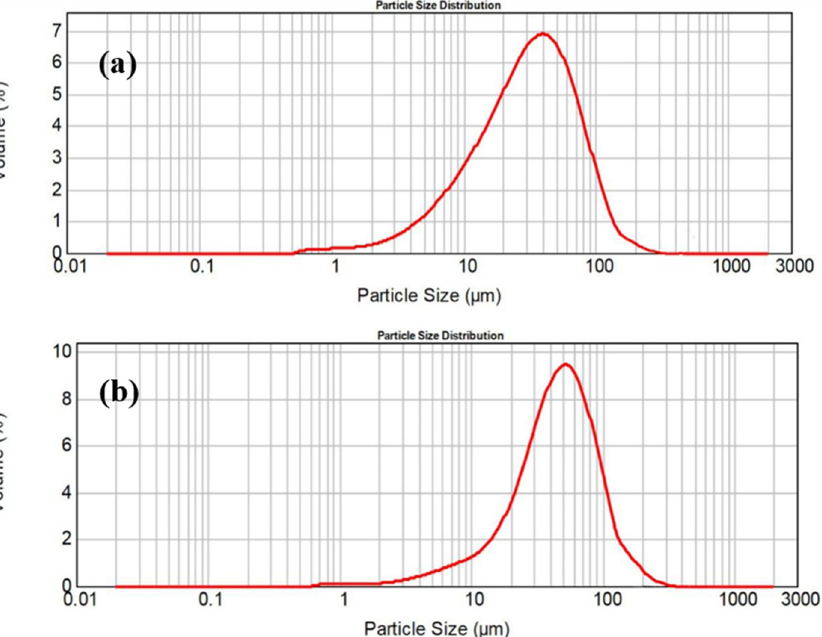
Figure 3. ( a ) Particle size distribution of sludge before electrochemical treatment, ( b ) Particle size distribution of sludge after electrochemical treatment.